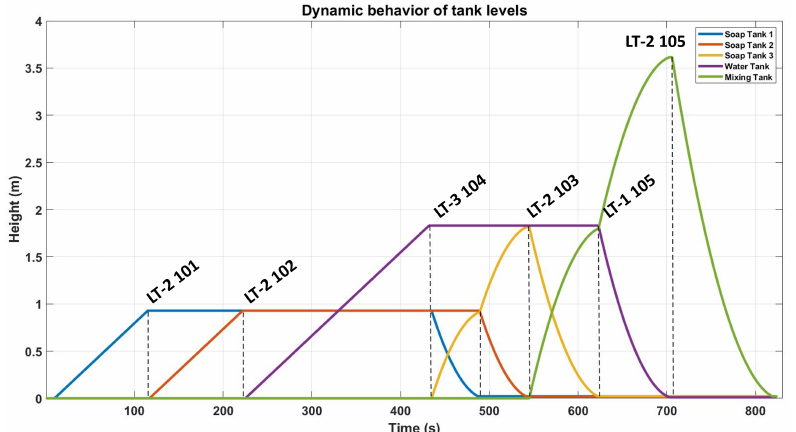
Figure 11. Dynamic behavior of the tanks levels through the “Large” sequence. First, Soap Tank 1 (blue) is filled until sensor LT-2 101 is active; next, Soap Tank 2 (orange) is filled until LT-2 102 is active; then, Water Tank (violet) is filled until LT-3 104 is active; then, both Soap Tank 1 and Soap Tank 2 are drained into Soap Tank 3 (yellow); after this, both Soap Tank 3 and water Tank are drained into Mixing Tank (green); finally the Mixing Tank is drained and the system returns to the initial state.